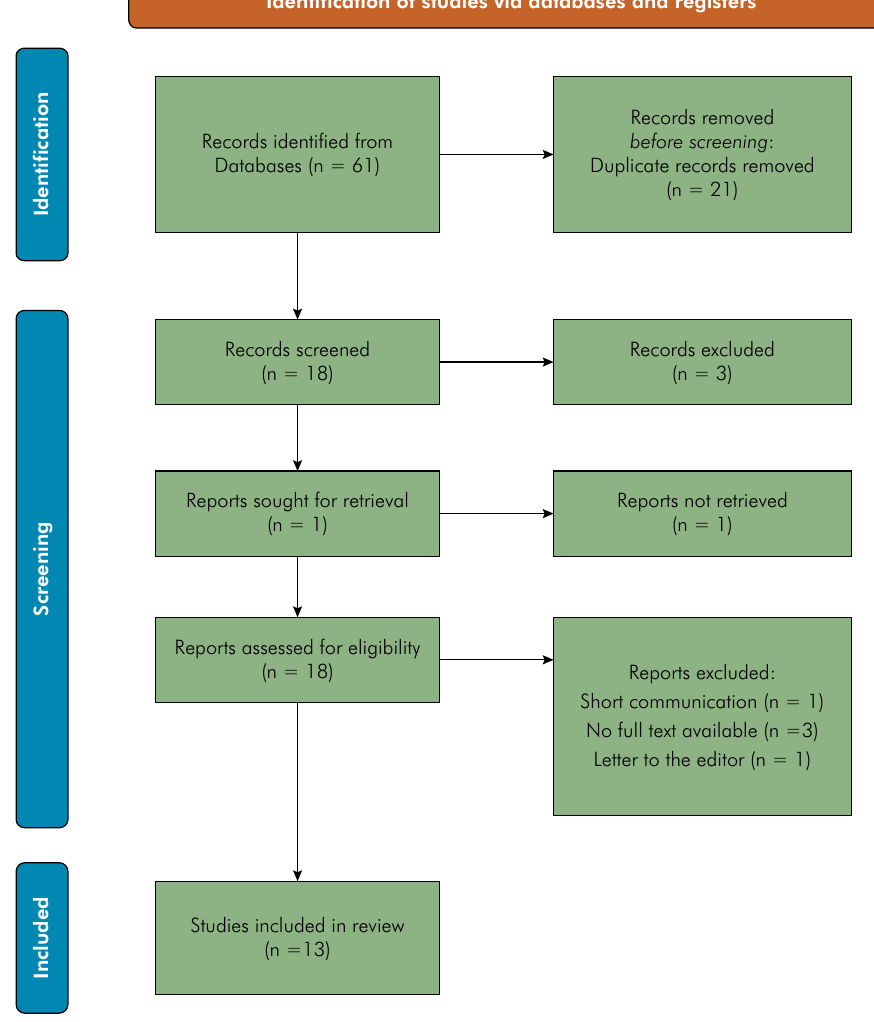
Figure 1. Prisma 2020 Flow Diagram for Propolis and COVID-19